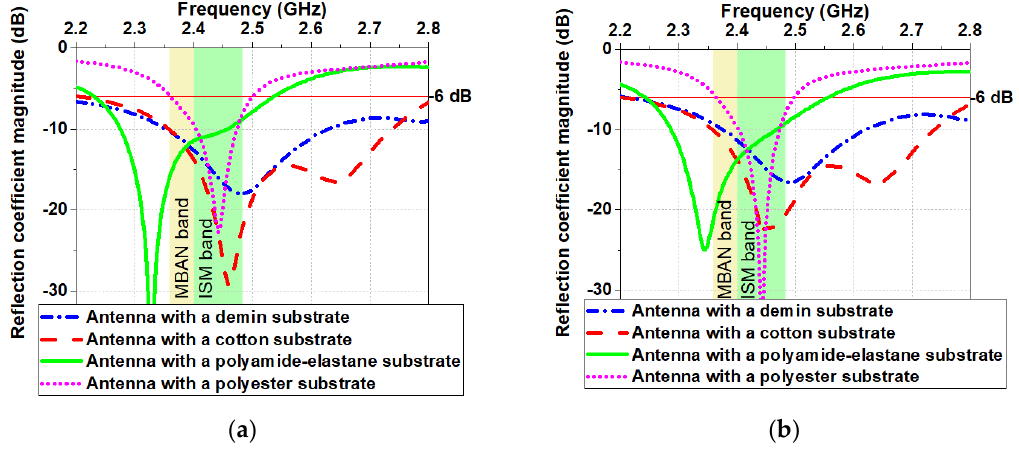
Figure 15. Measured reflection coefficient magnitudes when the antennas are: ( a ) in the free space; ( b ) on the homogeneous phantom.